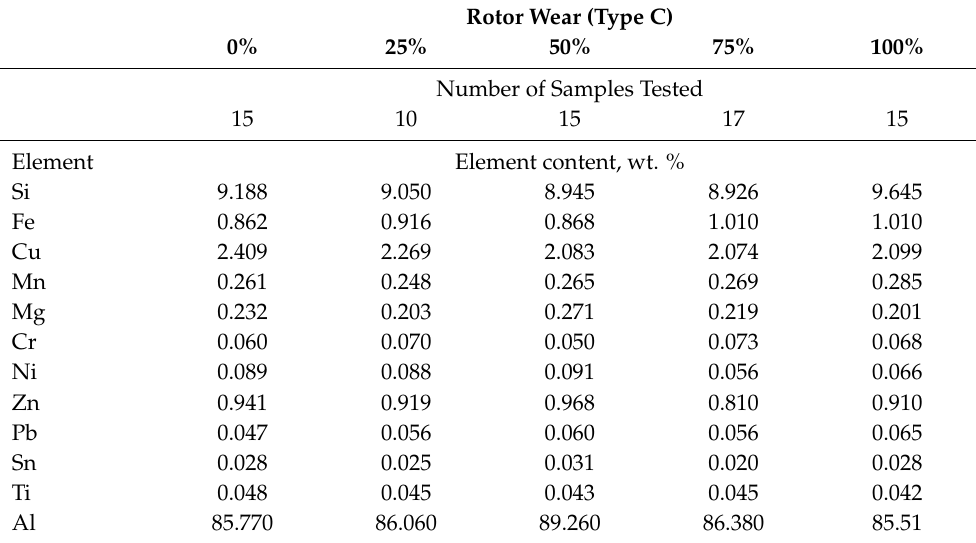
Table 9. Average chemical composition of samples taken from melts during operational experiments—type C